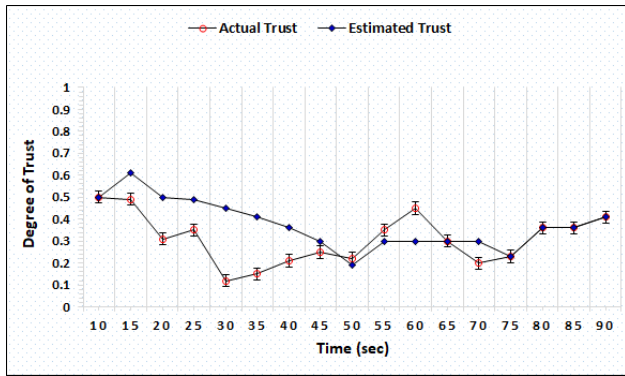
Figure 7. Trust degree of dishonest sensor.